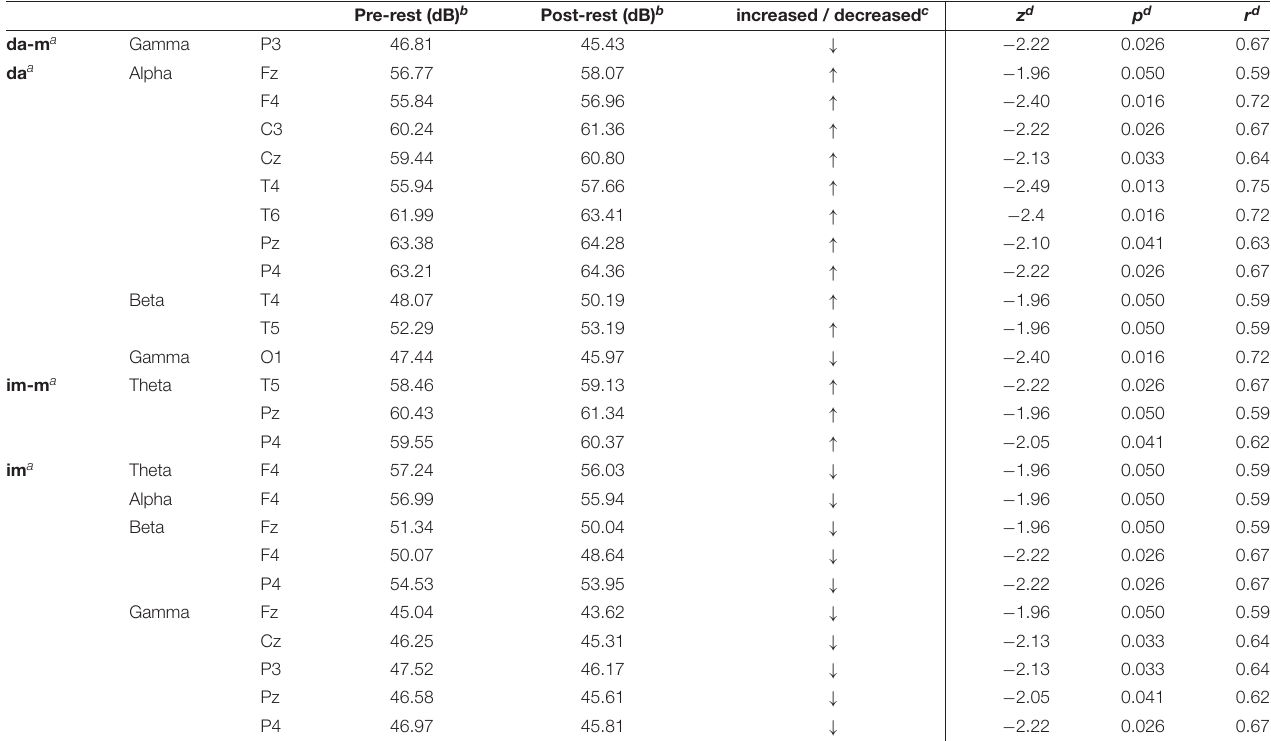
TABLE 1 | Significant time effects of power spectrum.